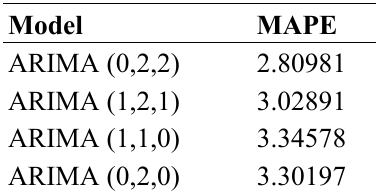
Table 2. Four different ARIMA models.